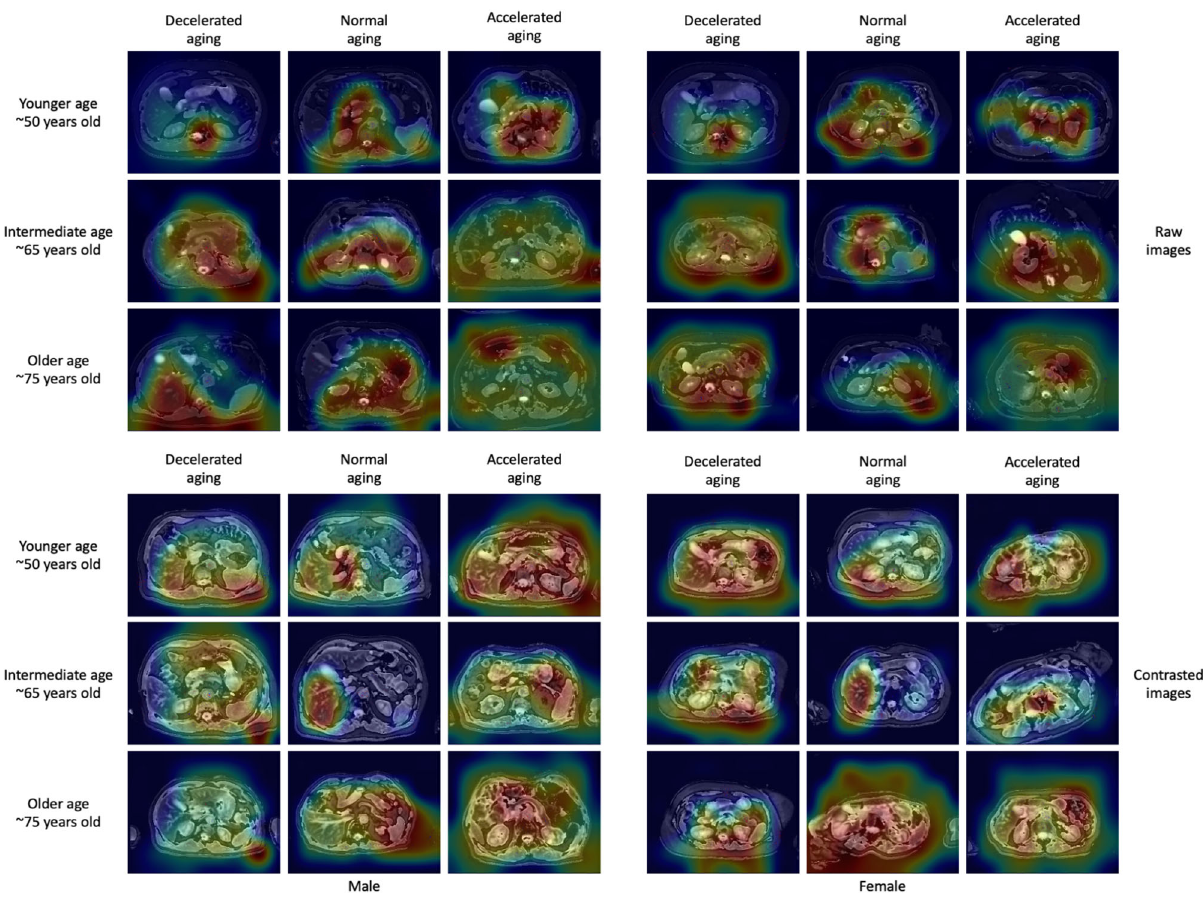
Fig. 4 Sample attention maps for pancreas MRI-based models on raw and contrasted images. “ Warm ” fi lter colors (more red) highlight regions of high importance according to the Grad-RAM map. Actual chronological ages are obscured.